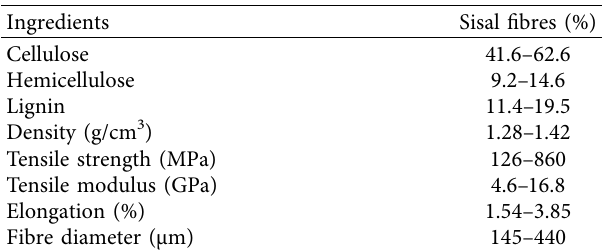
Figure 1: Challenges and technical problems faced during fabri- cation of natural fibre composites. Table 1: Chemical, physical, and mechanical composition of sisal fibres.